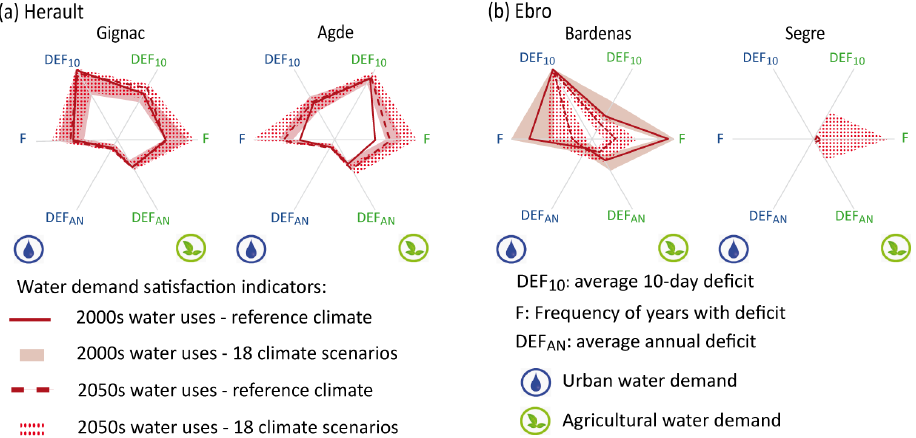
Figure 4. Water demand satisfaction indicators for urban and agricultural water demands under four combinations of water use and climate scenarios in two areas of (a) the Herault and (b) the Ebro basin. For all three indicators values range from 0 (no deficit) to 1 (maximum frequency or intensity of